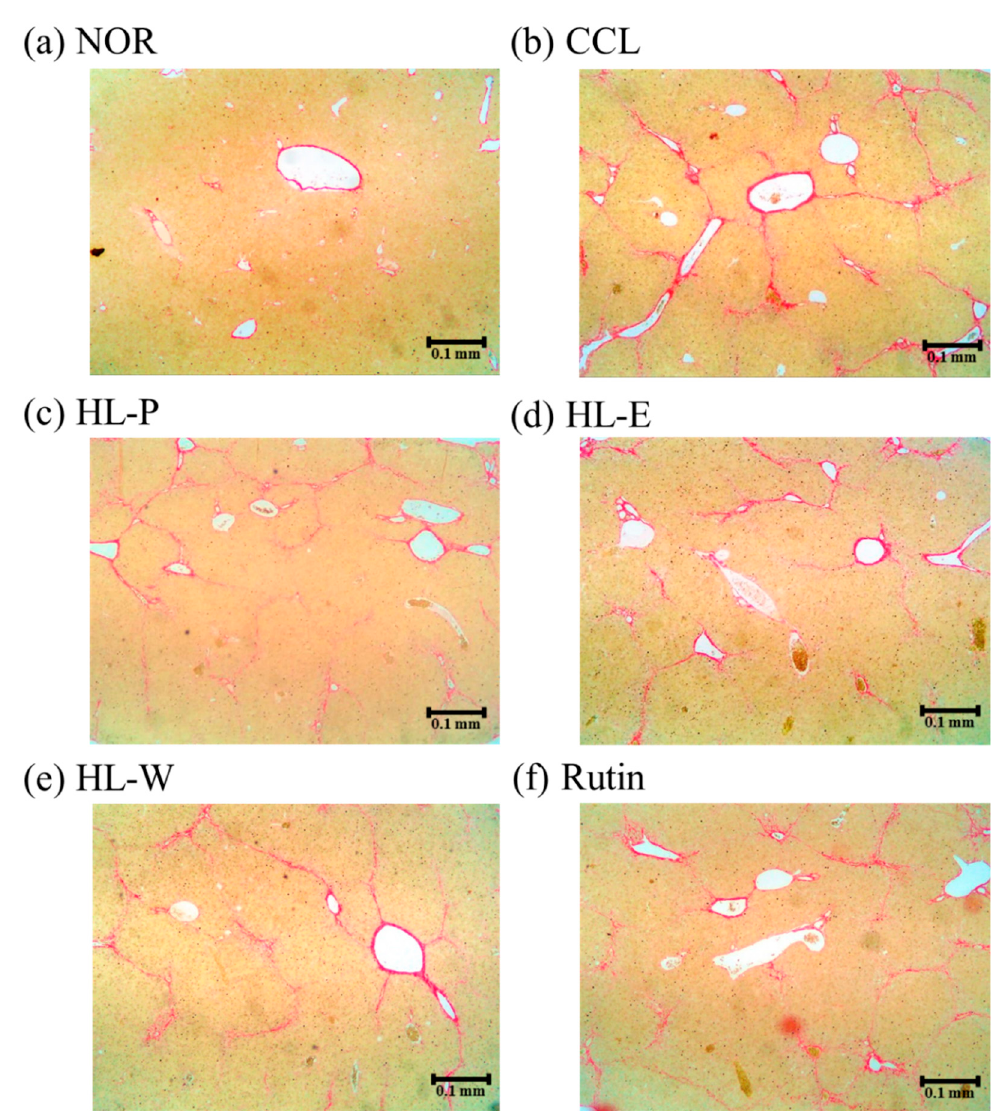
Figure 4. The effects of red quinoa and its extracts on hepatic collagen staining of CCl 4 -induced liver injury mice (Sirius red stain, 40×). ( a ) NOR: normal group. ( b ) CCL: CCl 4 -induced liver injury mice. ( c ) HL-P: CCl 4 -induced liver injury mice fed 5.13 g/kg (rutin 8.46 mg/kg) of red quinoa-powder. ( d ) HL-E: CCl 4 -induced liver injury mice fed 1.54 g/kg (rutin 16.4 mg/kg) of red quinoa-ethanol extracts. ( e ) HL-W: CCl 4 -induced liver injury mice fed 1.54 g/kg (rutin 3.92 mg/kg) of red quinoa-water extracts. ( f ) Rutin: CCl 4 -induced liver injury mice fed 16.4 mg/kg of rutin.